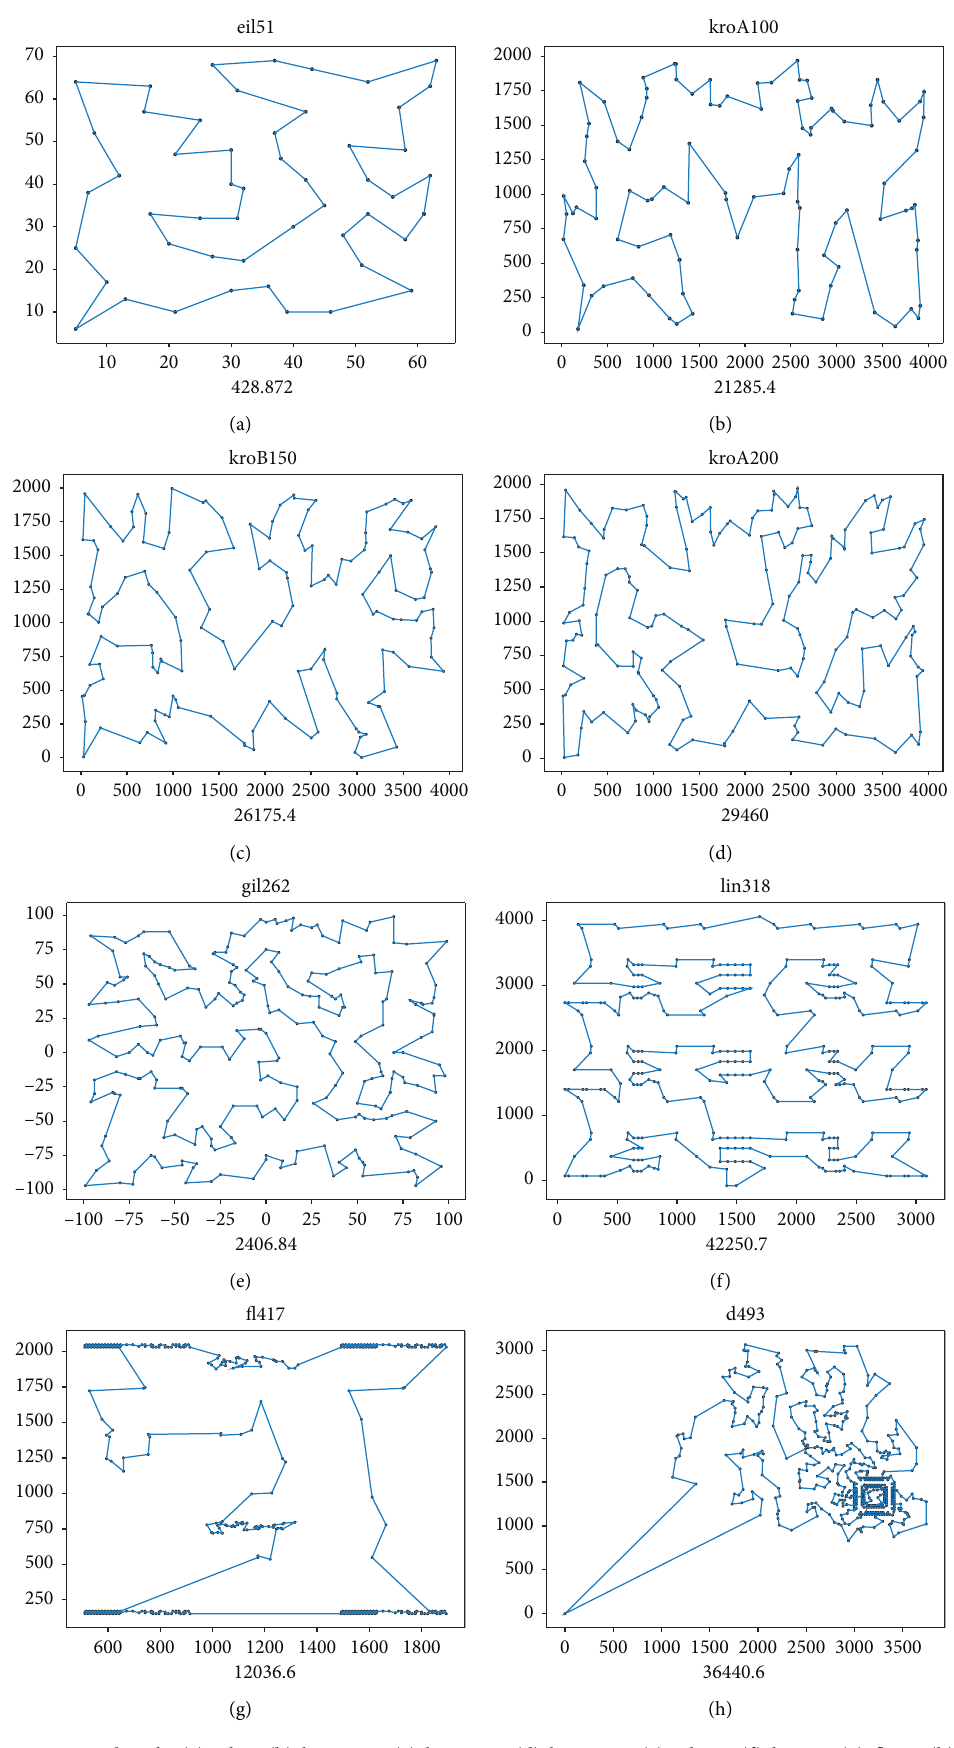
Figure 5: Optimal path. (a) eil51. (b) kroA100. (c) kroB150. (d) kroA200. (e) gil262. (f) lin318. (g) fl417. (h)